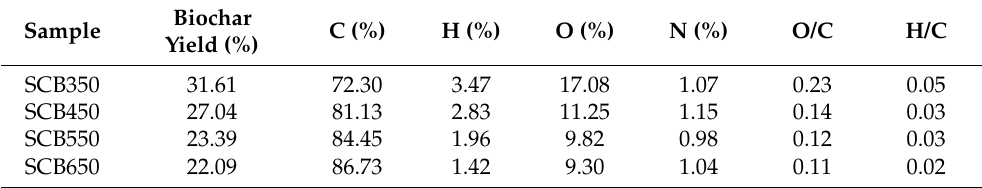
Table 1. Elemental analysis of sugarcane biomass pyrolyzed at various